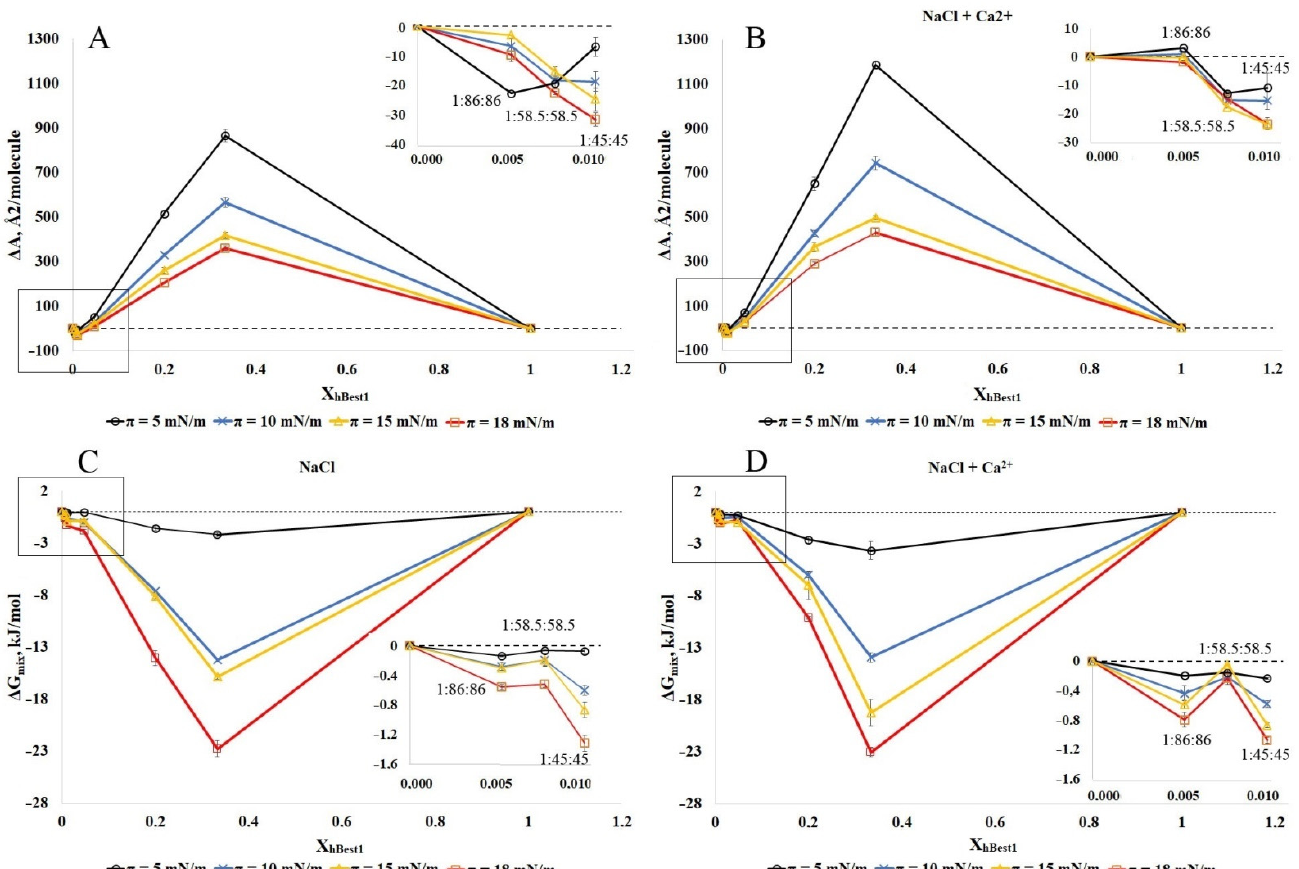
Figure 6. Plots of the deviation of the area from the additivity ( Δ A) ( A , B ) and the total free energy of mixing ( ∆ G π ) ( C , D ) versus film composition (X hBest1 ) at different surface pressures of hBest1/POPC/Chol monolayer in a subphase of 150 mM NaCl ( A , C ) and in 150 mM NaCl supple- mented with 0.5 µM CaCl 2 ( B , D ) at 35 ± 2 °C (inset: enlargement of the framed area). Regardless of the surface pressure and the presence of Ca 2+ , the Δ A in the hBest1/POPC/Chol monolayers have negative or zero values at X hBest1 < 0.02, corresponding to the biologically relevant conditions in the cell membrane and positive values at X hBest1 > 0.02. The ∆ A values of the hBest1/SM/Chol monolayers are positive, except the one at X hBest1 = 0.006, which oscillates at around zero (Figure 7A,B insets). The negative values suggest that in the ternary hBest1/POPC/Chol monolayers, the attractive interactions between hBest1 and the lipid molecules are stronger than the hBest1–hBest1 and